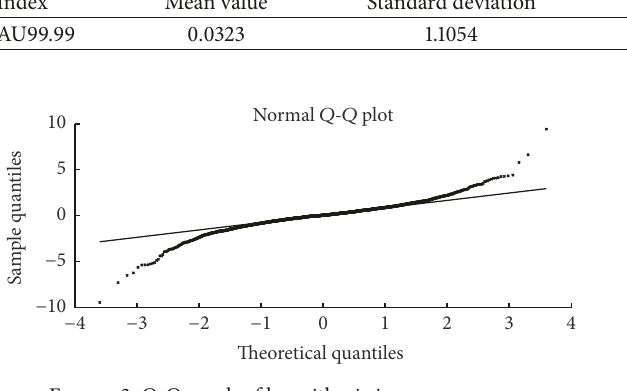
Figure 3: 𝑄 - 𝑄 graph of logarithmic income sequence.